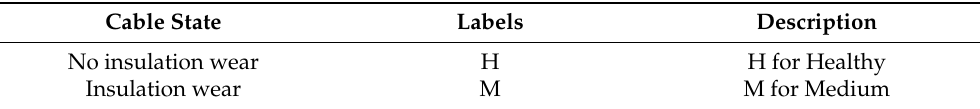
Table 1. Label table for the observations.